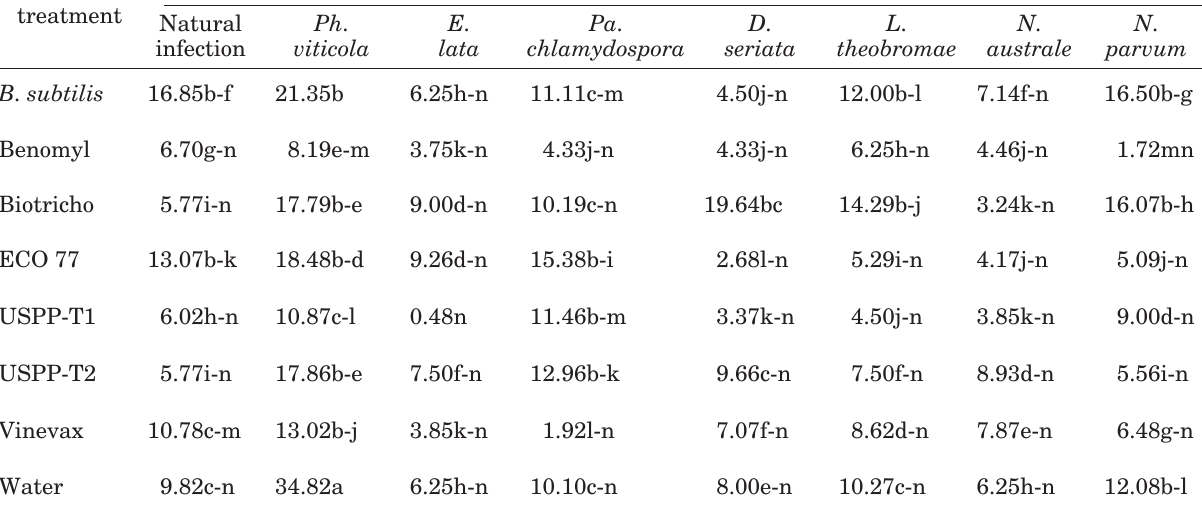
Table 5. Mean incidence of Phomopsis viticola that was isolated from pruning wounds 8 months after the fresh prun- ing wounds were treated with benomyl, Bacillus subtilis , two Trichoderma spp. (USPP-T1 and -T2), three commercial Trichoderma -based biocontrol products or water as pruning wound protectants, and challenged 7 days later by spray- inoculation with Eutypa lata , Phaeomoniella chlamydospora , Phomopsis viticola , Diplodia seriata , Lasiodiplodia theobromae , Neofusicoccum australe and N. parvum spore suspensions, or sprayed with sterile water to evaluate natural